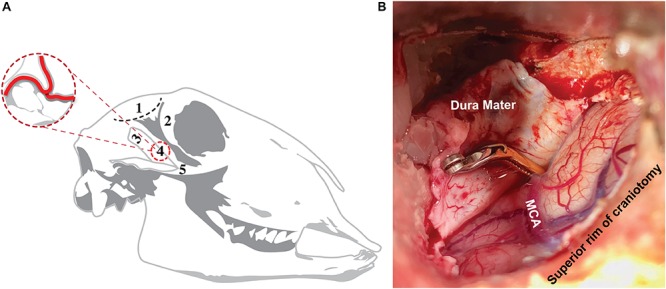
Surgical approach to ovine transient MCAO. Surgical approach (A), showing site of incision (1; black dashed line) posterior to the orbital rim (2) and superior to the coronoid process (3). This approach enabled the skull base to be accessed without disrupting the coronoid process or zygomatic arch (5), allowing for craniotomy (4) and direct access to the MCA, whilst ensuring post-operative recovery of the animal and the ability to masticate following the procedure. Superior view of craniotomy site (B) showing the aneurysm clip applied to the proximal MCA.